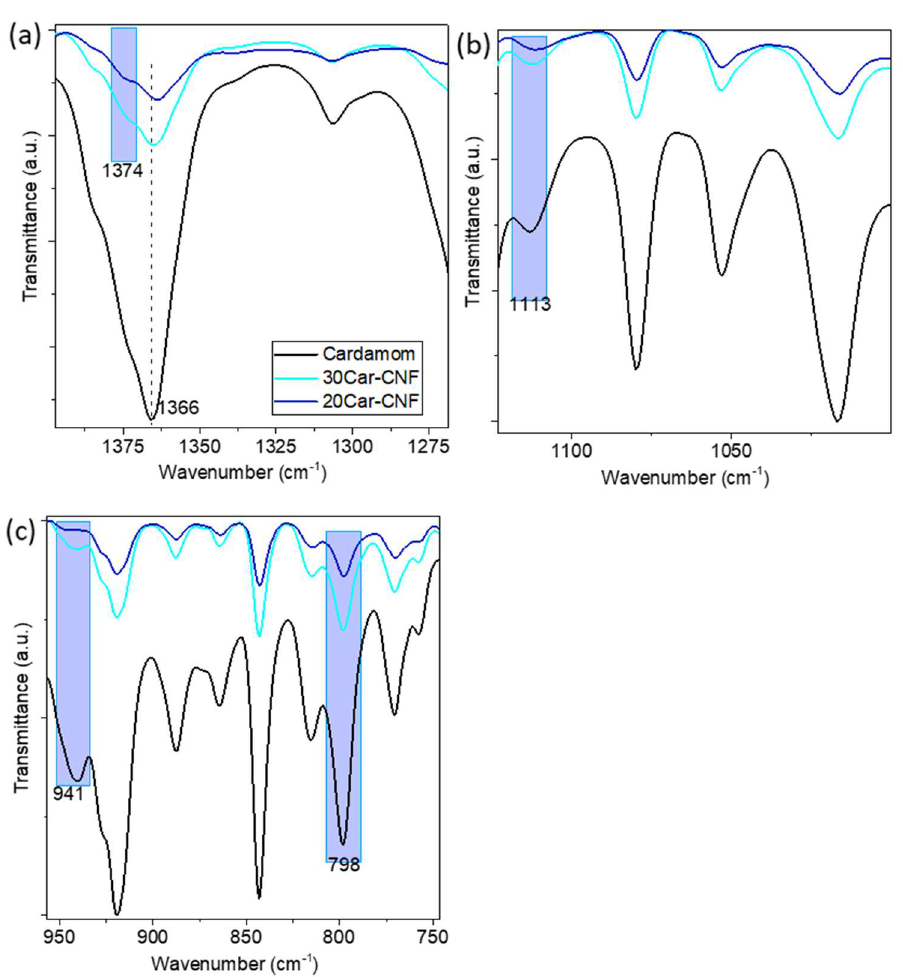
Figure 4. FTIR spectra of cardamomum essential oil and its CNF-stabilized emulsions: zoom in the regions ( a ) 1400–1275 cm − 1 , ( b ) 1120–1000 cm − 1 , and ( c ) 950–750 cm − 1 . regions ( a ) 1400–1275 cm −1 , ( b ) 1120–1000 cm −1 , and ( c ) 950–750 cm −1 . The EO peaks centered at 1366 cm − 1 (CH 2 bonds) and 1113 cm − 1 (CO The EO peaks centered at 1366 cm −1 (CH 2 bonds) and 1113 cm −1 (CO elongation